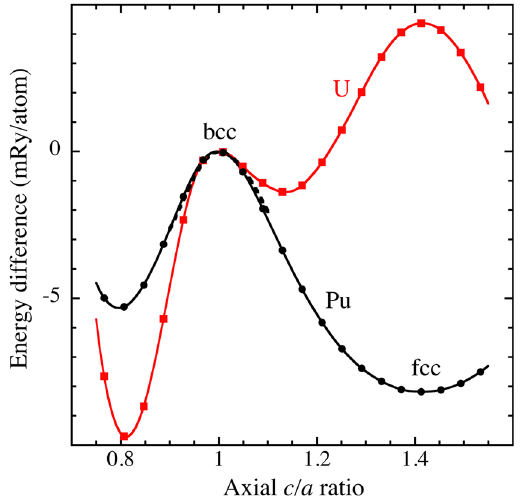
Figure 6. Calculated zero-temperature energy difference, relative to the bcc phase (paramagnetic, see main text), as a function of axial c/a ratio for uranium and plutonium. The dashed curve shows results for anti- ferromagnetic